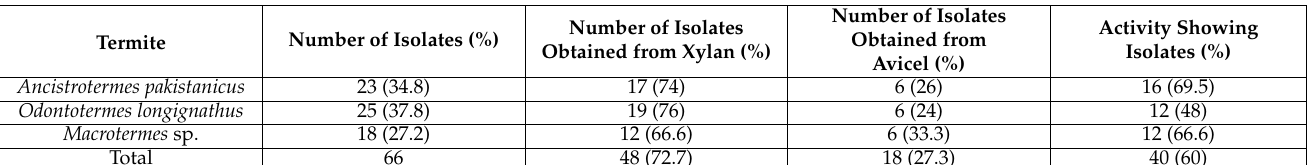
Table 1. Profile of the culturable bacteria within the termite gut systems along with their isolation sources and substrates showing lignocellulase